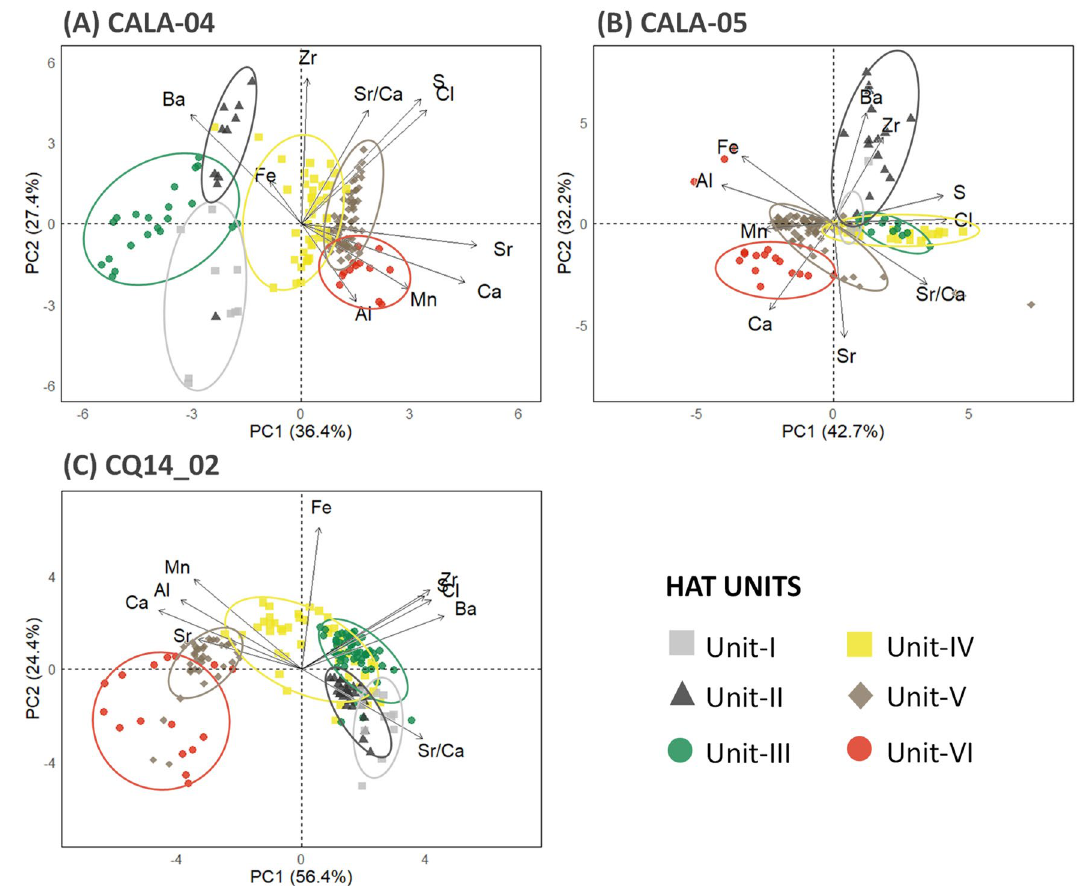
Figure 8. Statistical analysis based on XRF-CS datasets for the cores CALA-04, CALA-05 and CQ14_02. PCA biplots showing the contributions of 10 elemental concentrations to explain the HAT units in the core CALA- 04 ( A ), CALA-05 ( B ) and CQ14_02 ( C ). The overlaps of the areas delimitated by the ellipses indicate higher similarities among the units, while the proximity of the units to the geochemical vectors suggest stronger contribution of them to differentiate the respective groups of the cases (1 cm vertical resolution samples). The percentages presented in the axis titles correspond to variance explained by each principal component